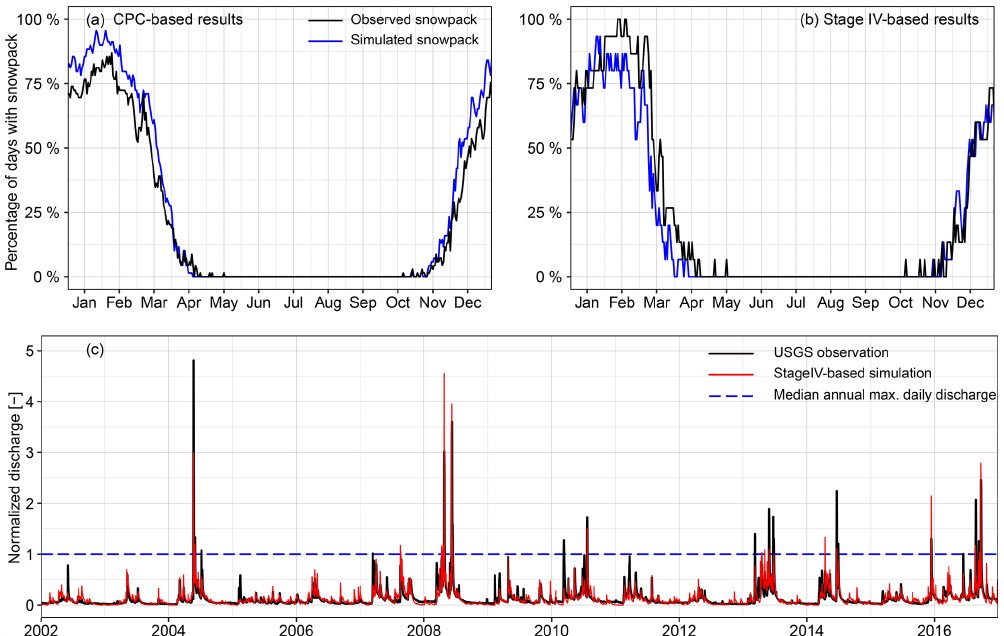
Figure 5. Percentage of days with nonzero snowpack present in observations and simulations (a, b) and hydrograph validation for Stage IV- based simulation (c) . For each day within a year, the percent with nonzero snowpack is calculated as the ratio of the number of years in which snowpack is present on that day to the total years (69 years for CPC and 15 years for Stage IV). Observed and simulated hydrographs are normalized by the median annual flood, which is indicated by the dashed blue